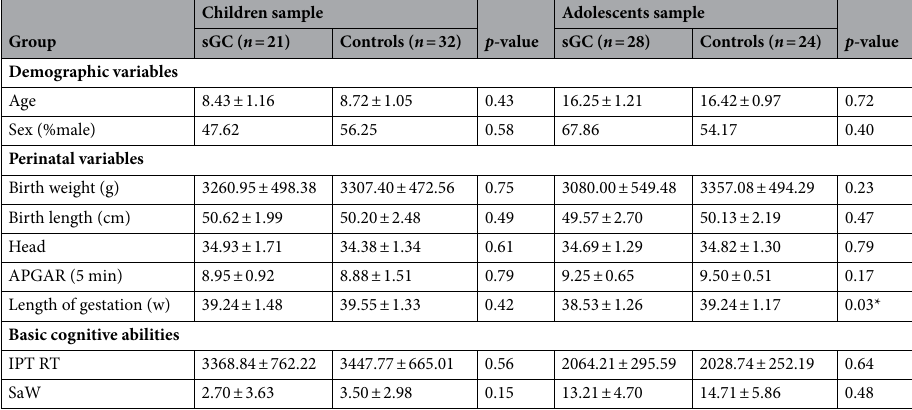
Table 1. Sample characteristics including demographic variables, perinatal variables and basic cognitive abilities. Values are displayed in mean ± SD. APGAR is a measure of the health of the newborn that assesses Appearance, Pulse, Grimace, Activity and Respiration. IPT RT reaction times in Identical Pictures Task, SaW correct reports in Spot-a-Word-Task. Where data is normally distributed, independent samples t-tests were